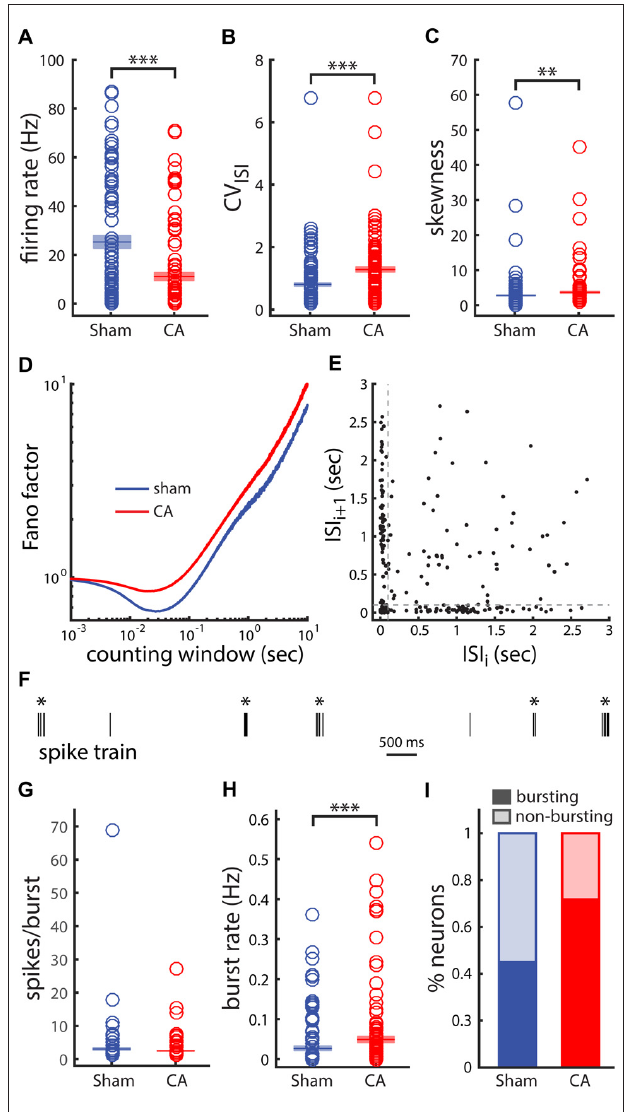
FIGURE 6 | Variability and burst firing of activity from neurons in the entopeduncular nucleus (EPN) of the basal ganglia is affected by ischemic injury. (A) Firing rate is lower in CA neurons than in Sham neurons as previously observed. (B) The coefficient of variation (CV) of the interspike intervals (ISIs) is larger in CA neurons than in Sham neurons. (C) The skewness (a measure of asymmetry) of the ISI histogram (ISIH) of CA neurons is larger than in Sham neurons. This asymmetry arises from a relatively larger, more distributed tail of ISI values in the CA neuron ISIHs. (D) The Fano-factor of spike counts as a function of counting window is larger for Sham neurons than CA neurons for the range of counting windows examined. (E) The ISI return map for an example CA neuron reveals burst-like firing in this case. The spread of points along the axes arise from a long ISI followed by a short ISI and vice versa. These ISI pair sequence arise at the initiating of a burst and at the end of a burst, respectively. (F) The spike train of the same example neuron shows clearly distinguishable burst and isolated spike events. (G) The number of spikes per burst in Sham and CA neurons is similar. (H) The burst rate averaged across all neurons in the groups is larger for CA neurons than for Sham neurons. (I) 45% of Sham neurons exhibit burst activity compared to 72% of CA neurons. ∗ Indicates p < 0.05, ∗∗ indicates p < 0.01 and ∗∗∗ indicates p <